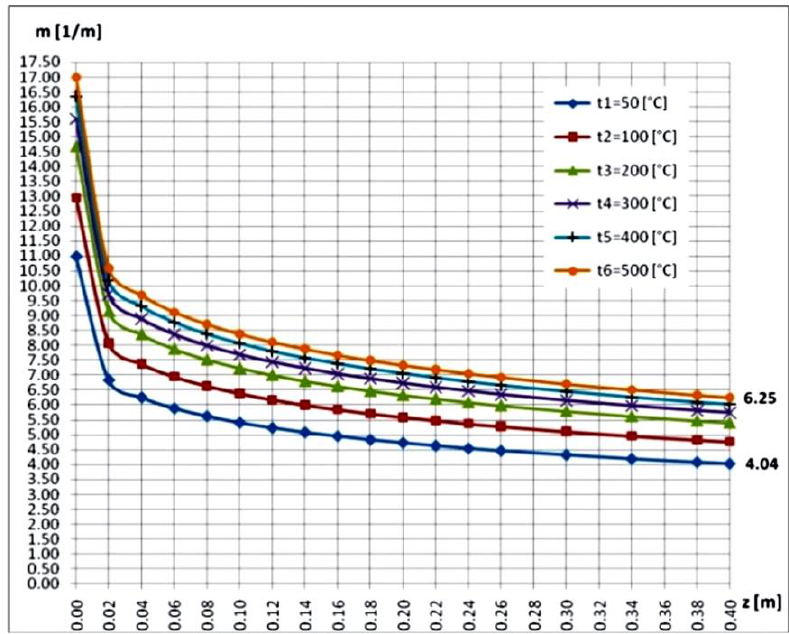
Figure 20. The variation in the parameter “ m ” along the first significant interval of the bar (